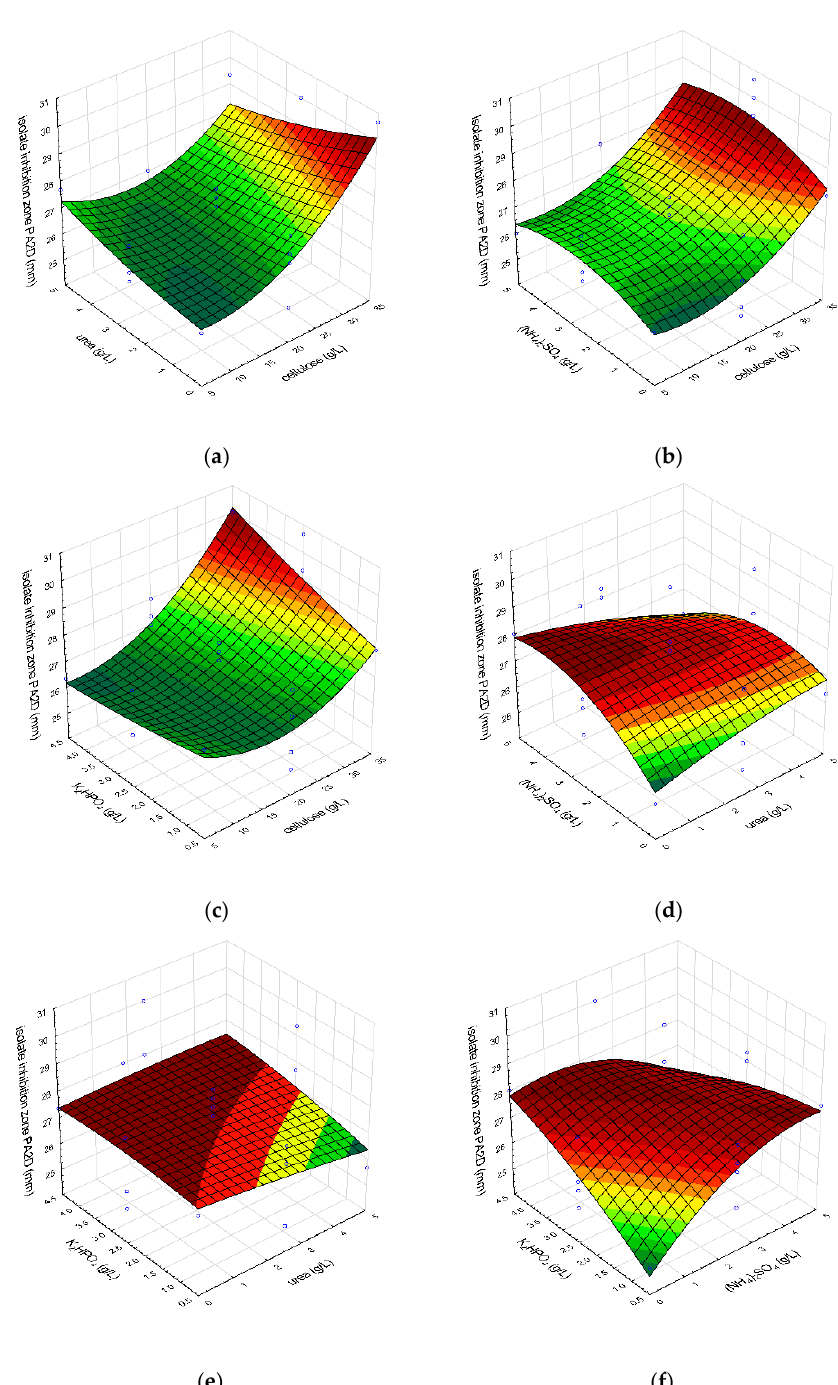
Figure A2. Response surface plots for effects of nutrients’ content on inhibition-zone diameter for Aspergillus flavus PA2DSS (RSM methodology): ( a ) cellulose and urea, ( b ) cellulose and (NH 4 ) 2 SO 4 , ( c ) cellulose and K 2 HPO 4 , ( d ) urea and (NH 4 ) 2 SO 4 , ( e ) K 2 HPO 4 and urea, ( f ) K 2 HPO 4 , and (NH 4 ) 2 SO 4 .